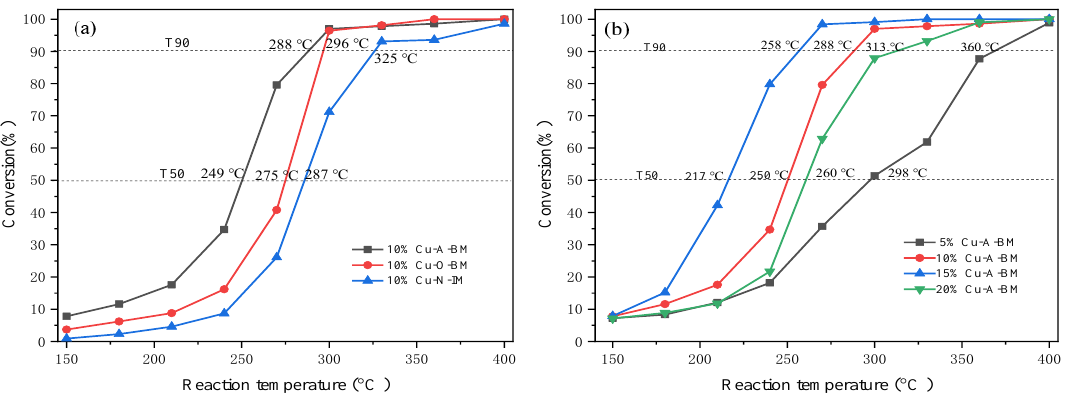
Figure 9. Catalytic activity of 10% Cu-A-BM, 10% Cu-O-BM, 10% Cu-N-IM ( a ) and W% Cu-A-BM catalysts ( b ).